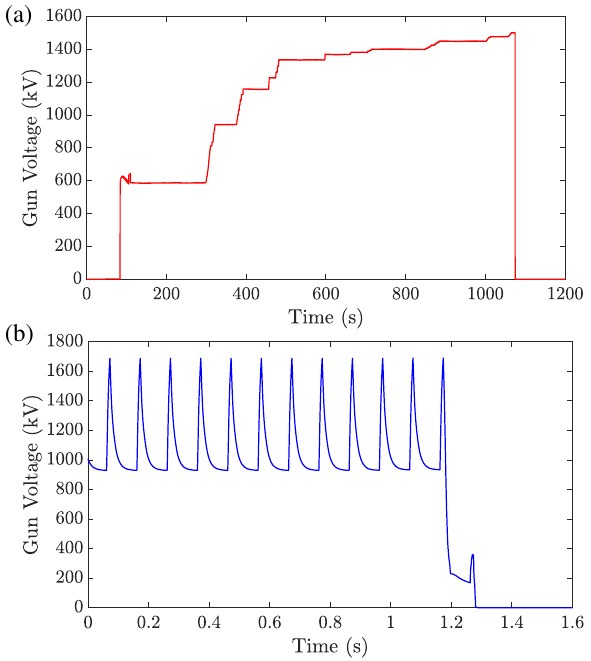
FIG. 7. The highest achieved cw (a) and pulsed (b) cavity voltage after the first case of He